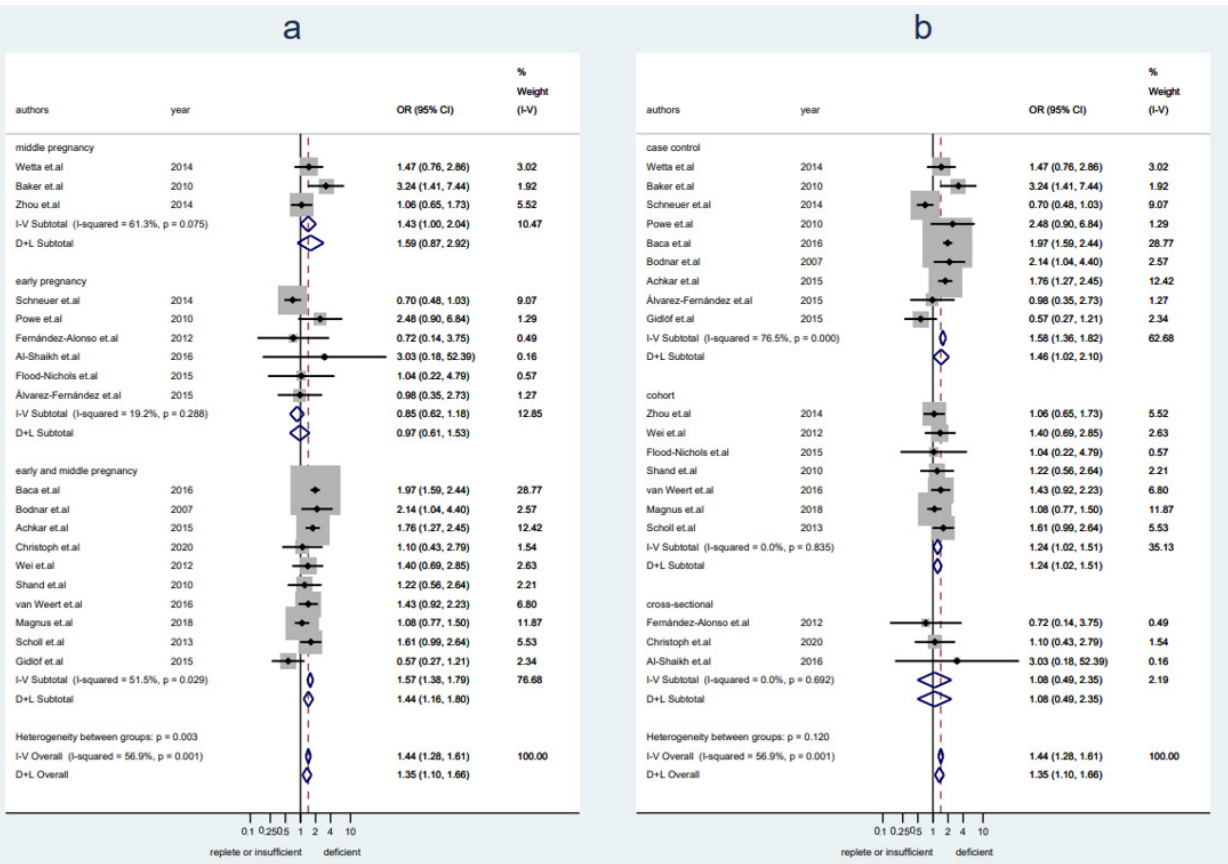
Figure 2. Studies evaluating replete vitamin D levels or insufficient versus deficient vitamin D lev- els. ( a ): Studies were stratified by gestational weeks (early, middle, and early and middle not speci- fied); ( b ): studies were stratified by the study design.